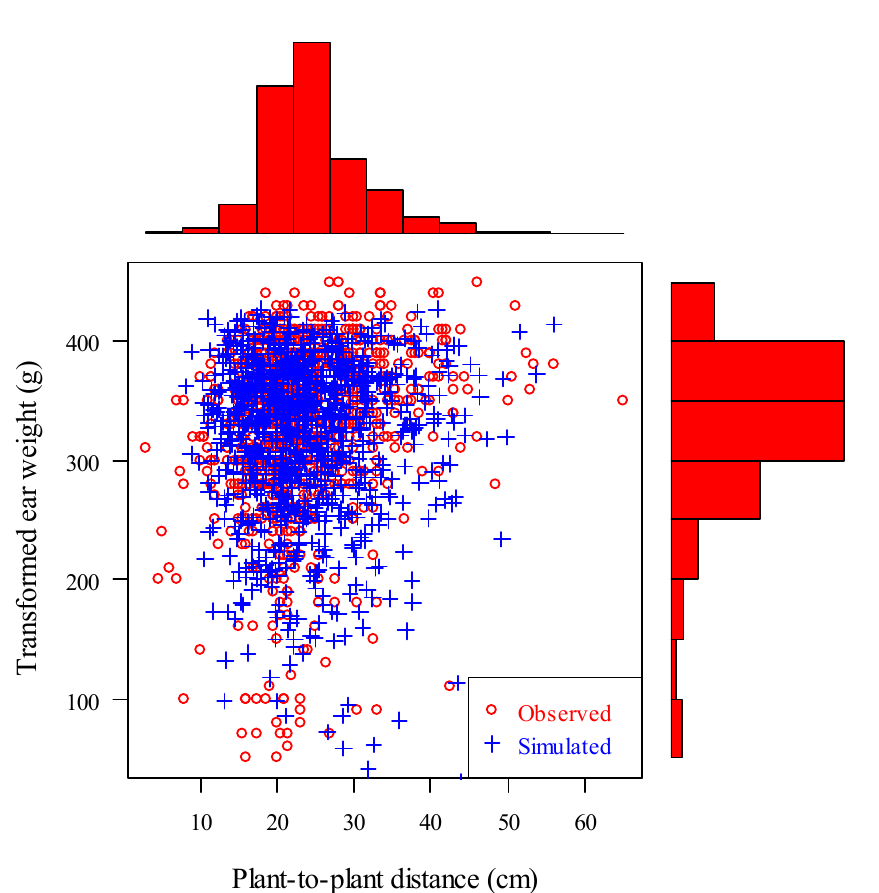
Figure 7. Observed and simulated plant-to-plant distance and ear weight data pairs. Circles of red color indicate the observed data, while blue crosses show the simulated ones.